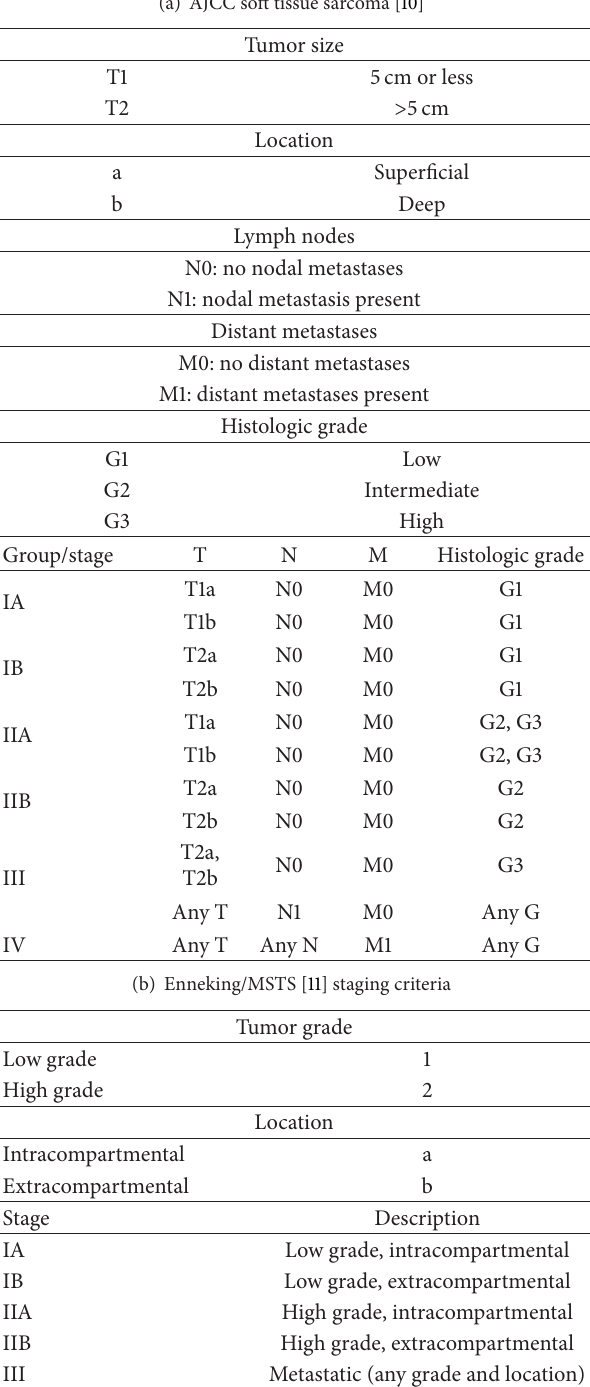
Table 1: (a) AJCC soft tissue sarcoma [10] and (b) Enneking/MSTS [11] staging